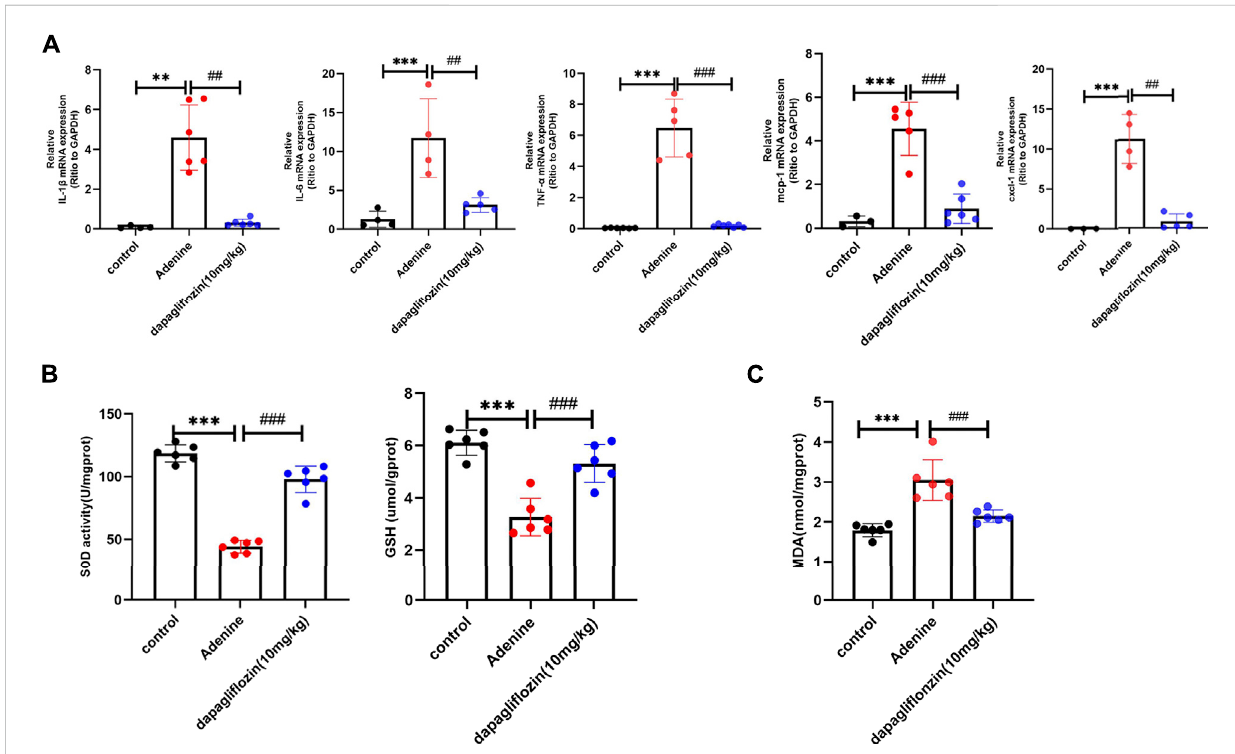
FIGURE 6 Dapagli fl ozin inhibited the activation of TGF- β 1/MAPK pathway in 0.2% adenine diet-fed mice. (A) Real time PCR showing the expression of TGF- β 1 in the renal tissue of each group. (B, C) Western blot showing the expression of p-ERK and p-P38 in each group. Values are means ± SD. *** p < 0.001 adenine diet group compared with the control group; ## p < 0.01 dapagli fl ozin treatment group compared with the adenine diet group; ### p < 0.001 dapagli fl ozin treatment group compared with the adenine diet